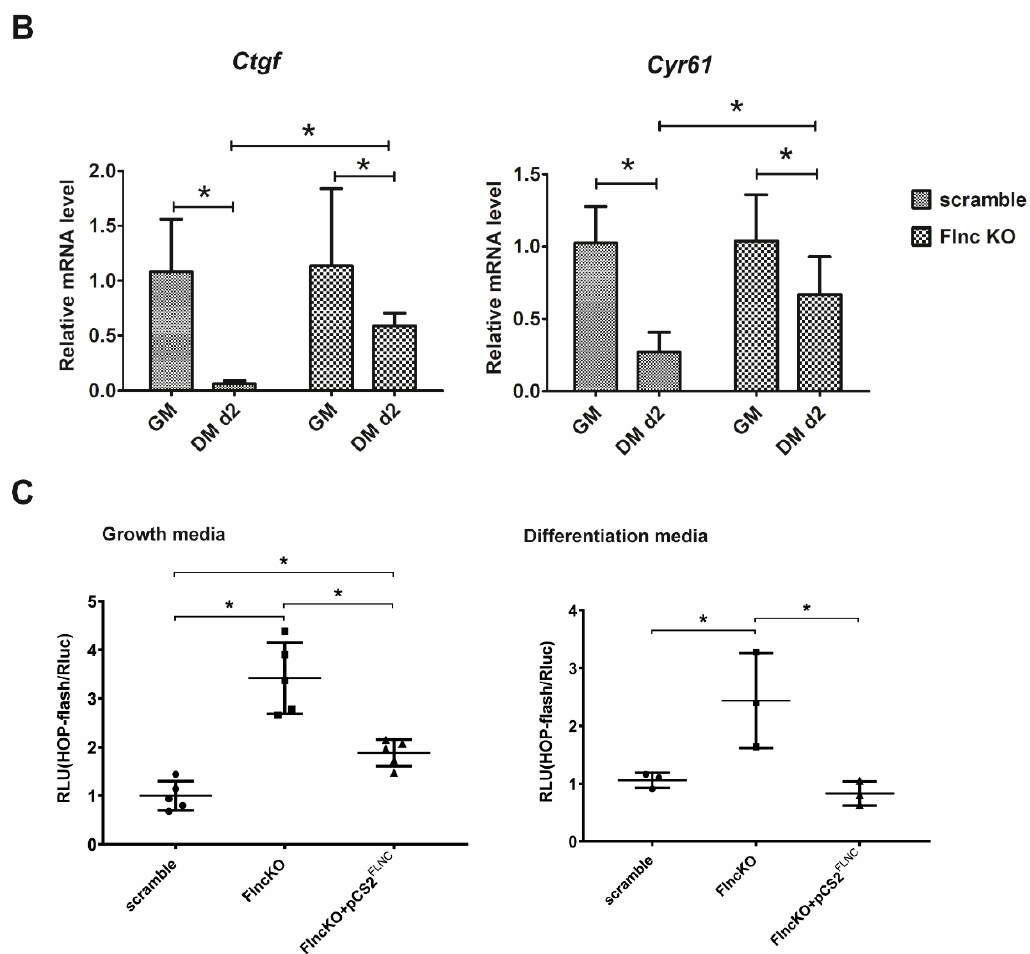
Figure 3. Loss of FLNC a ff ects TEAD-YAP / TAZ activity in myoblasts during di ff erentiation. (A) HOP-flash luciferase assay was performed in both under proliferating condition and during di ff erentiation. In low density conditions no di ff erences of TEAD-YAP / TAZ activity were obtained, whereas in high density FlncKO cells exhibit significantly greater increase of TEAD-YAP / TAZ activation. 48 h after changing of the growth media to di ff erentiation media in both FlncKO and scramble cell line we observed significant decrease of TEAD-YAP / TAZ activity. ( B ) Expression of downstream YAP / TAZ-targeted genes were evaluated using qPCR. In scramble cell line mRNA expression of Ctgf and Cyr61 become reduced 48 h after myogenic di ff erentiation induction, when FlncKO cells exhibit weaker reduction of Ctgf and Cyr61 expression under the same di ff erentiation conditions. ( C ) Hippo pathway activity was restored in FlncKO cell line 24 h after add-back of FLNC using transfection with pCS2 FLNC plasmid, when myoblasts were cultivated in growth media, and 48 h after induction of myogenic di ff erentiation. For all * p <